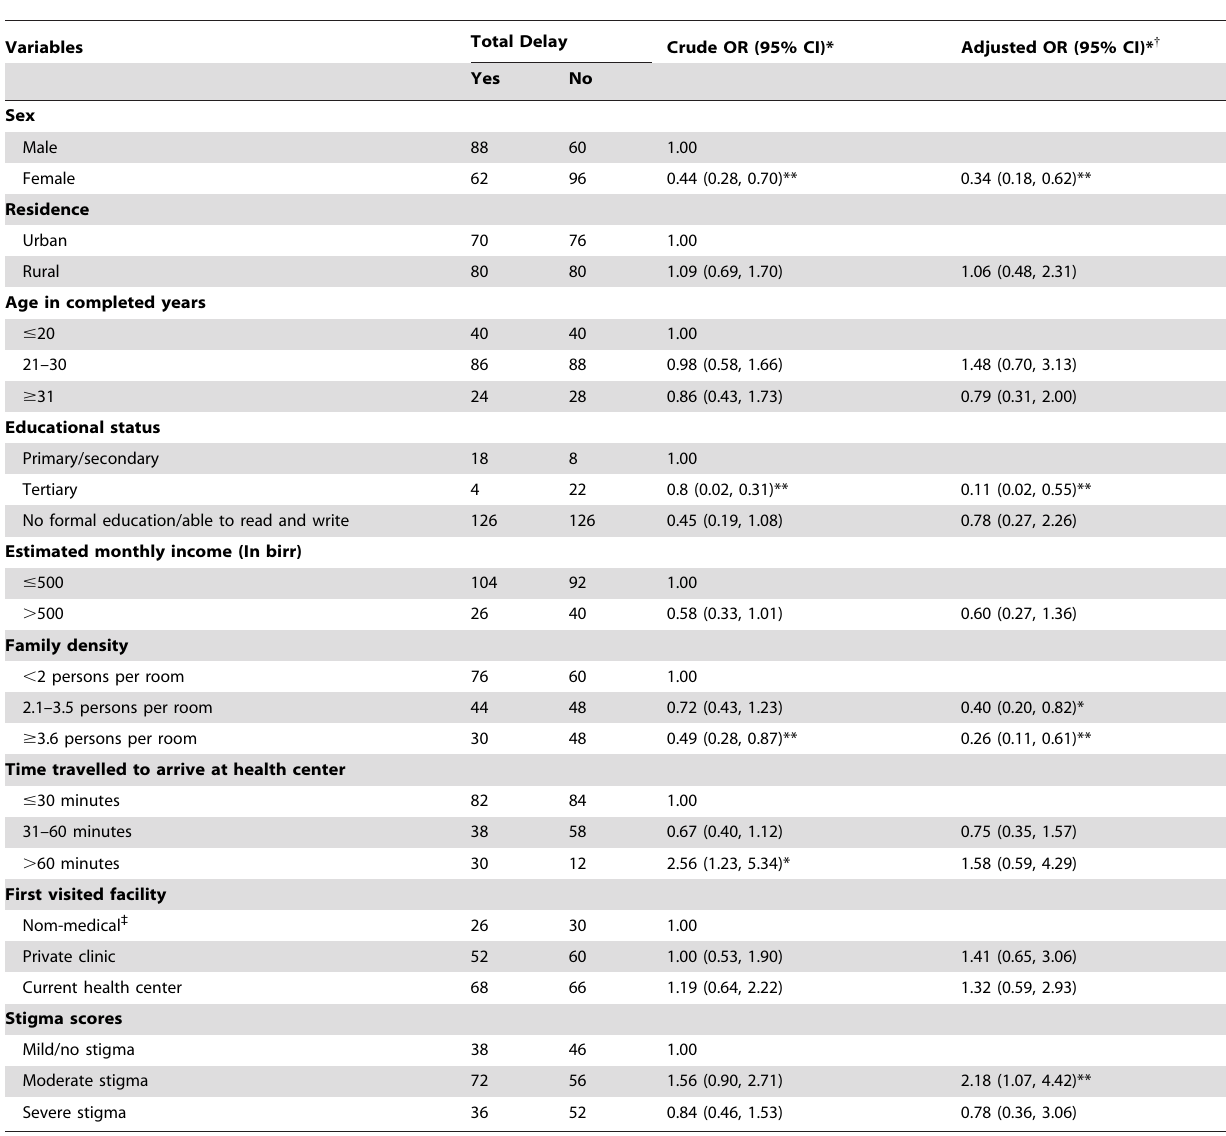
Table 4. Multivariate analysis of risk factors of total delay among smear positive PTB patients, southern Ethiopia, June-December